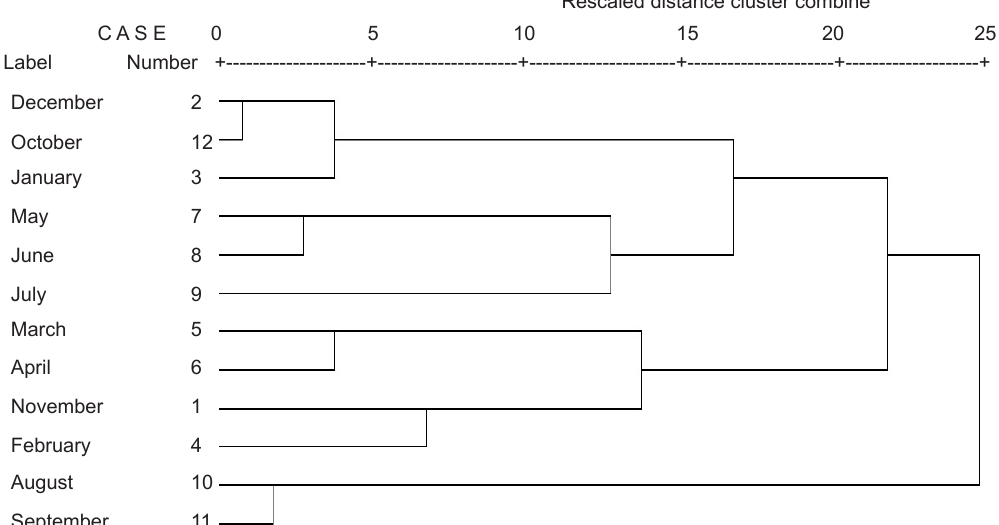
Rescaled distance cluster